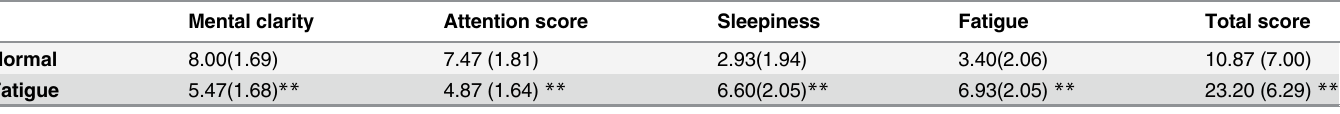
Table 3. Mean summary data for fatigue questionnaire